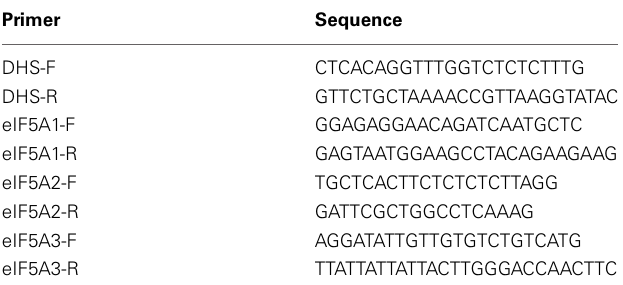
Table 1 | Primers for real-time